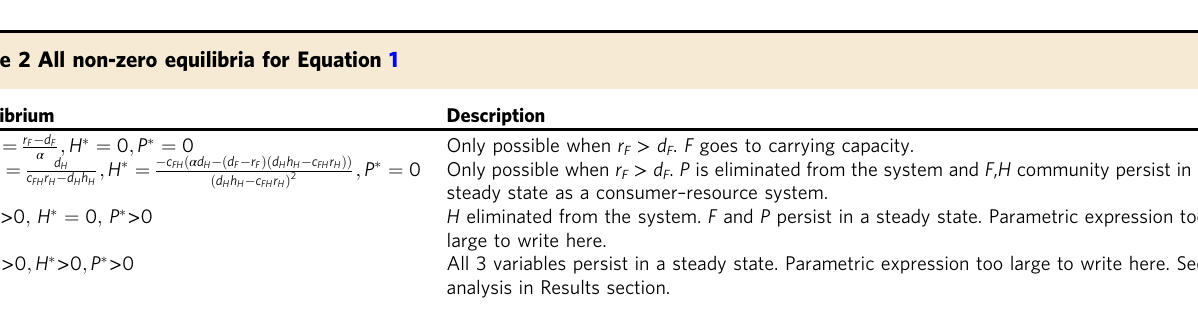
Table 2 All non-zero equilibria for Equation 1 Equilibrium